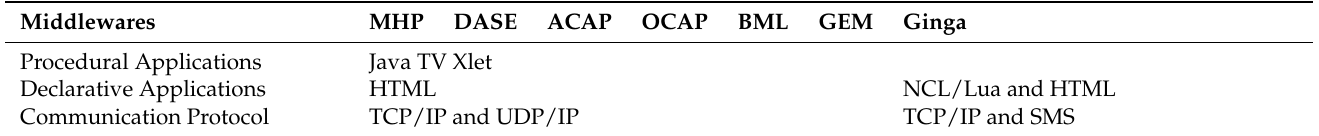
Table 1. Early ITV middlewares